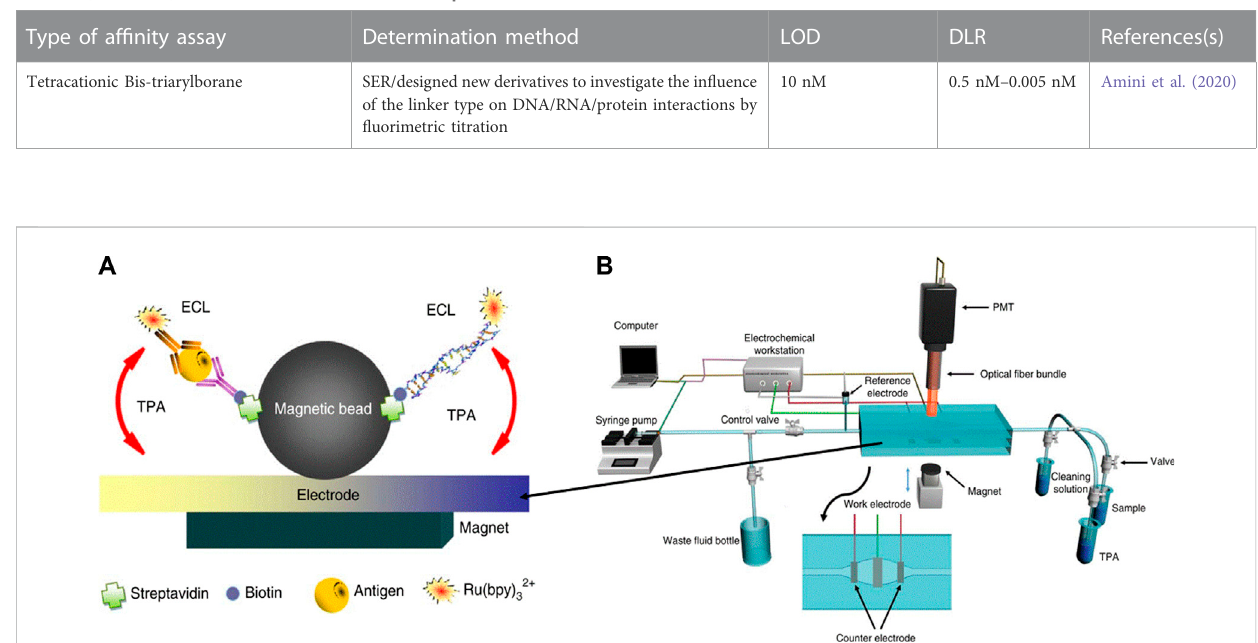
FIGURE 9 (A) Schematic illustration of magnetic based (MB) ECL for hepatitis B antigen model and nucleic acid target ,whereas antibody of nucleic acids are labeled with biotin and Ru(bpy), (B) MB based ECL measurement and detection system (Zhou et al.